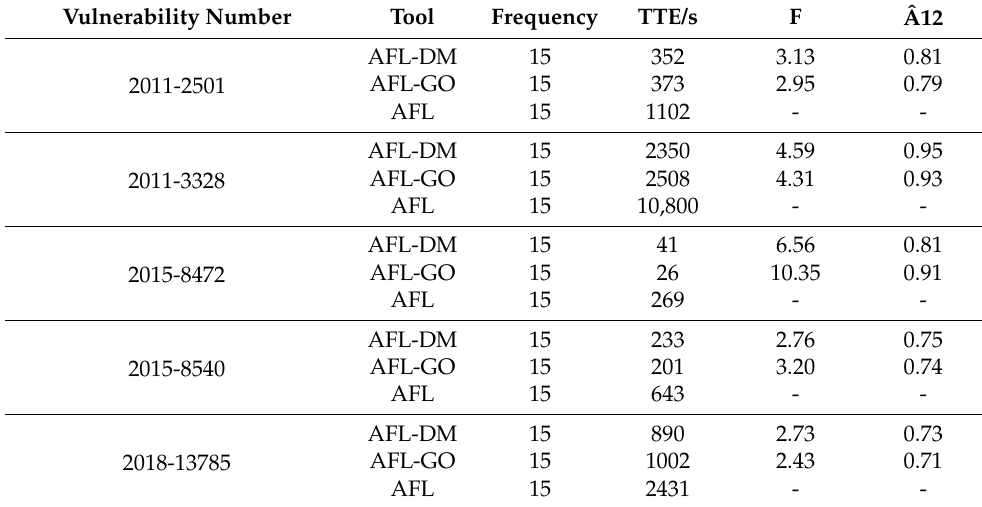
Table 2. Vulnerability reproduction results of Libpng.